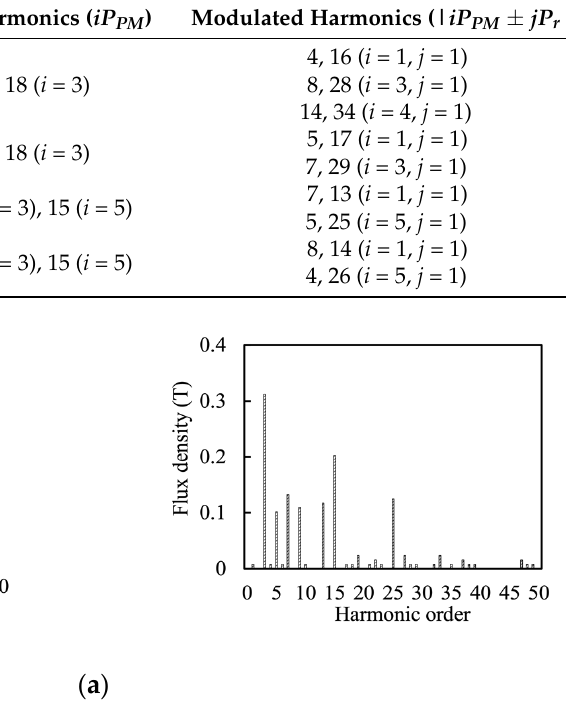
Table 3. Characteristics of no-load air-gap flux-density harmonics of the four candidates.